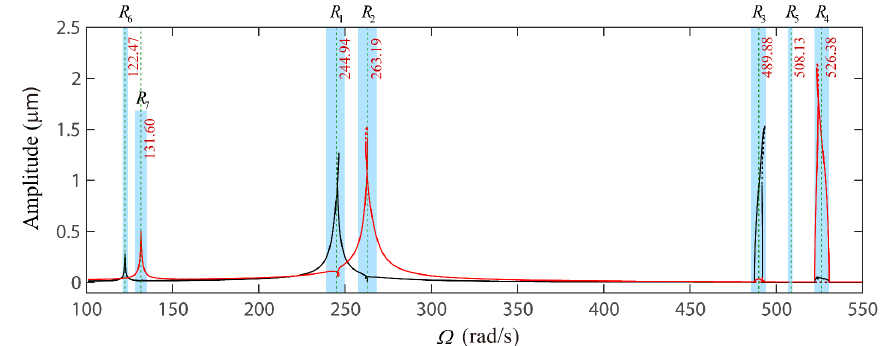
Figure 8. For δ 0 = − 1.5 μ m, stable (solid) and unstable (dashed) VC periodic peak-to-peak frequency–response curves in x (red line) and y (black line) directions.